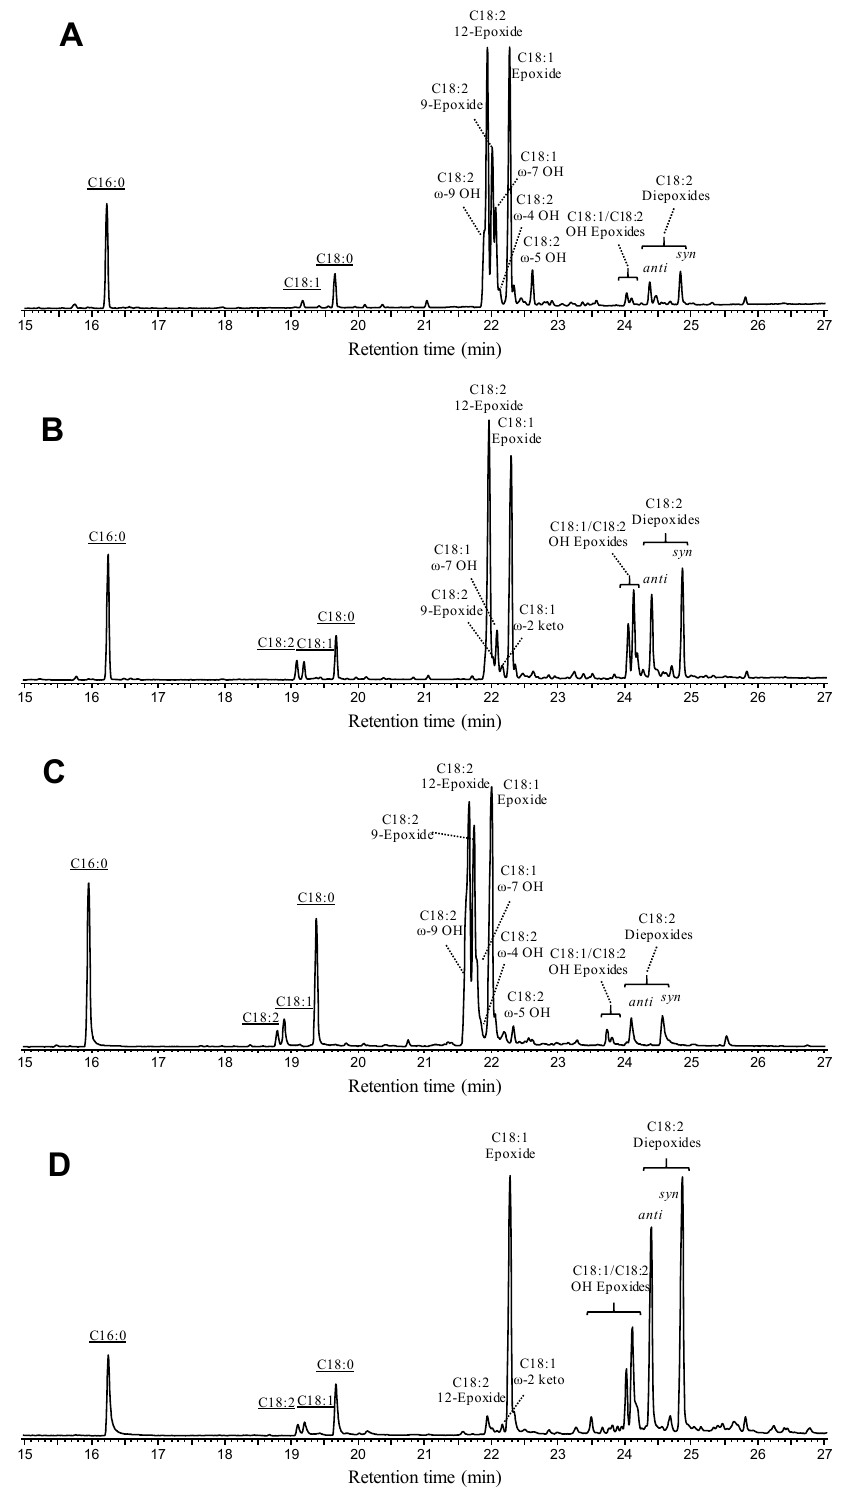
Figure 4. GC-MS profiles of UPO reactions with sunflower oil hydrolyzate. ( A , B ) Initial treatment of 0.1 mM oil hydrolyzate with 0.25 µ M r Cvi UPO and its F88A/T158A variant, respectively, for 30 min in 50 mM phosphate (pH 7) containing 20% acetone and 1 mM H 2 O 2 . ( C , D ) Optimized treatment of 10 mM oil hydrolyzate with 25 µ M r Cvi UPO and 50 µ M F88A/T158A for 60 min in 50 mM phosphate buffer (pH 7) containing 30% acetone and 25 mM H 2 O 2